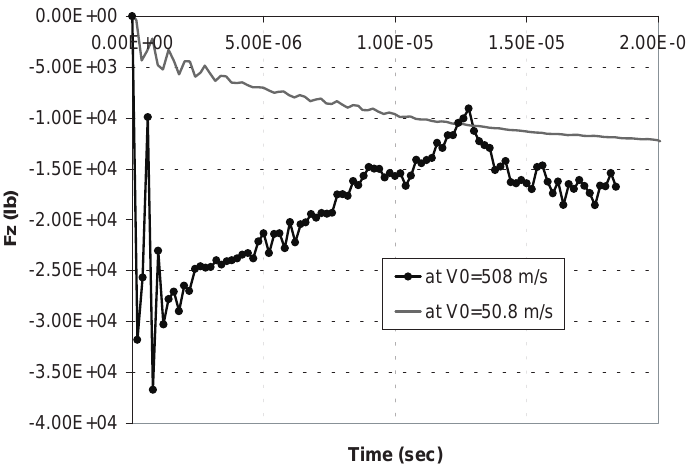
Fig. 13. A comparison of time history of z-component of the total contact force ( F z ) between the projectile and the composite plate.